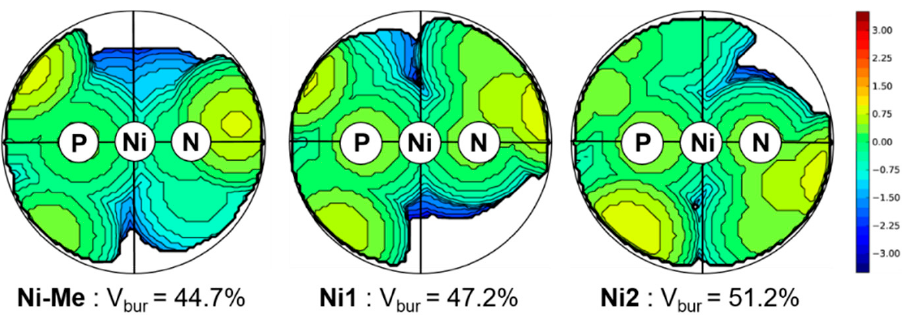
Figure 3. Topographic steric maps of different nickel complexes.